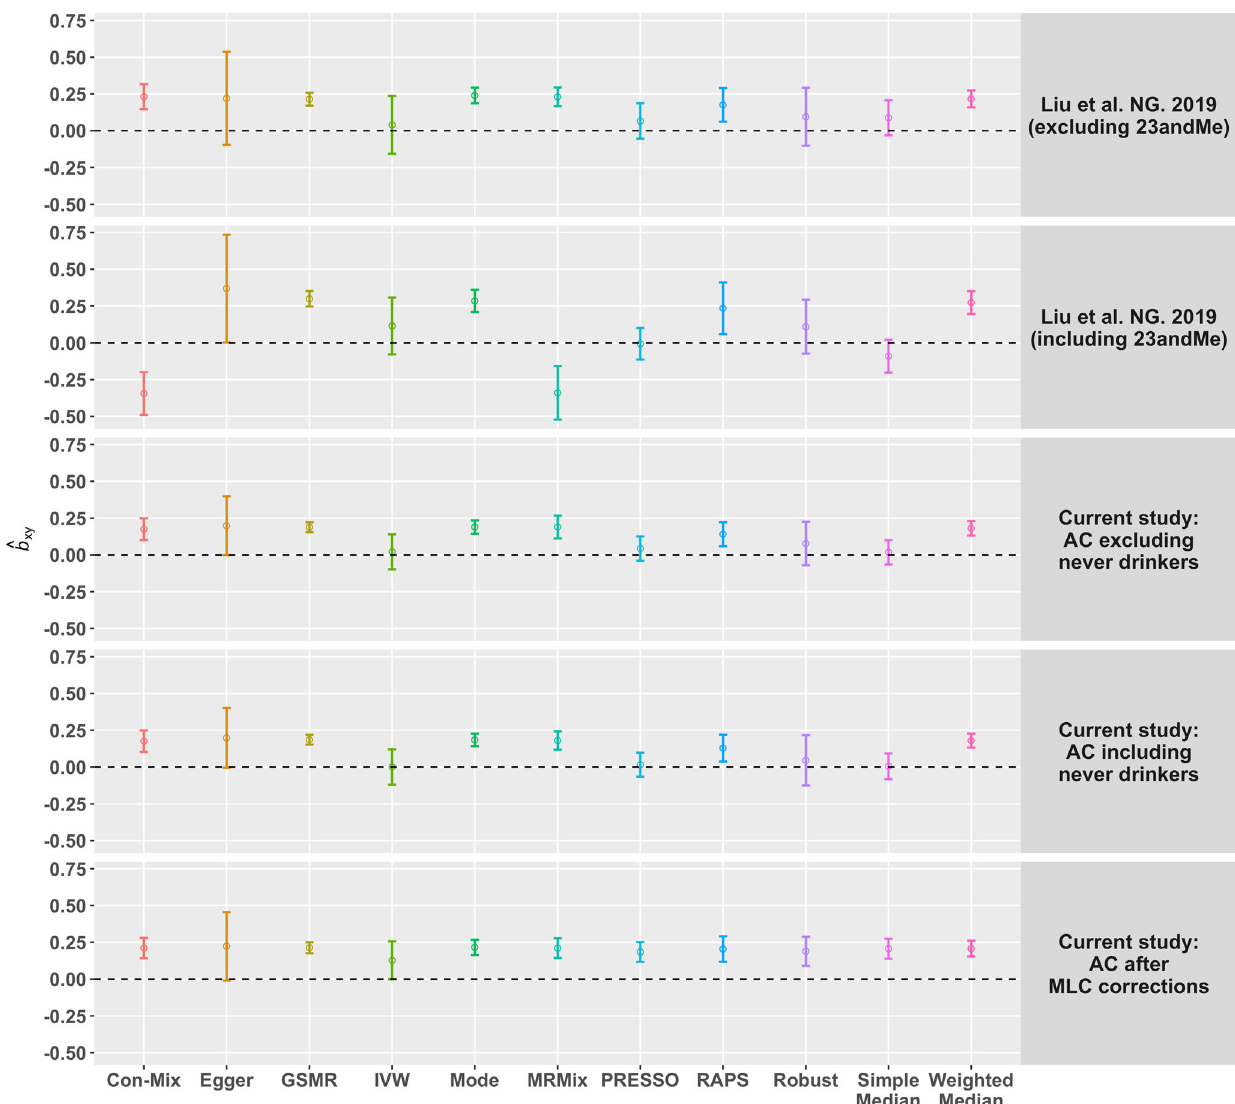
Fig. 4 Estimates of causal effect of AC on BMI using different MR methods. The colour of the circle denotes different MR methods. The methods on the x-axis is ranked based on alphabetic order from the left to the right. The y-axis is the b xy estimates from each method. The error bars denote 95% con fi dence interval of the estimates. The row-wise panels indicate fi ve different GWAS summary data sets for AC. The horizontal black dashed line indicates b xy = 0. The sample sizes ( n ) of the fi ve AC data sets are 537,349 (Liu et al. excluding 23andMe), 941,280 (Liu et al. including 23andMe), 358,409 (excluding never drinkers), 372,897 (including never drinkers), and 336,469 (after the MLC corrections), ¼ 0 : 232 with s.e. = 0.037 for METT and ^ r ¼ 0 : 390 OAA ( ^ r g g